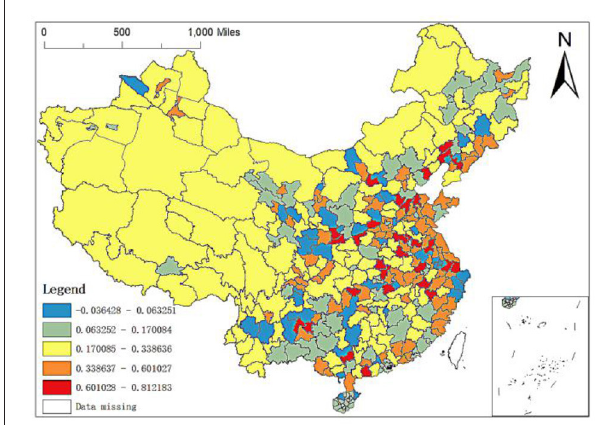
FIGURE 11 | Spatial distribution of regression coefficients of the number of city level in the GWR